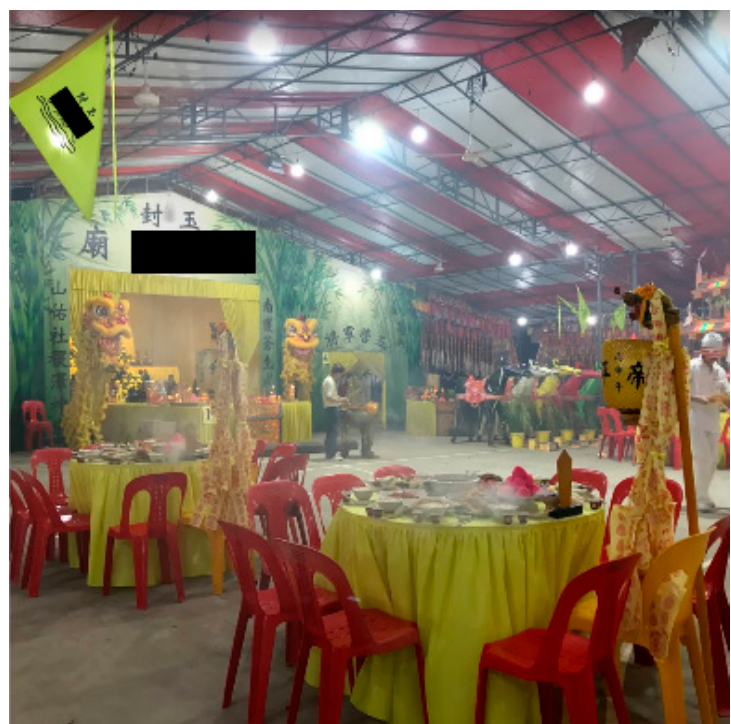
Figure 3. A Vegetarian “Nine Table Feast” for the Nine Emperor Gods at a Makeshift Temple. Kemenyan incense cups were burnt to cleanse the temple, creating an “atmosphere” of sacredness. The name of the sintua has been redacted to protect its anonymity.